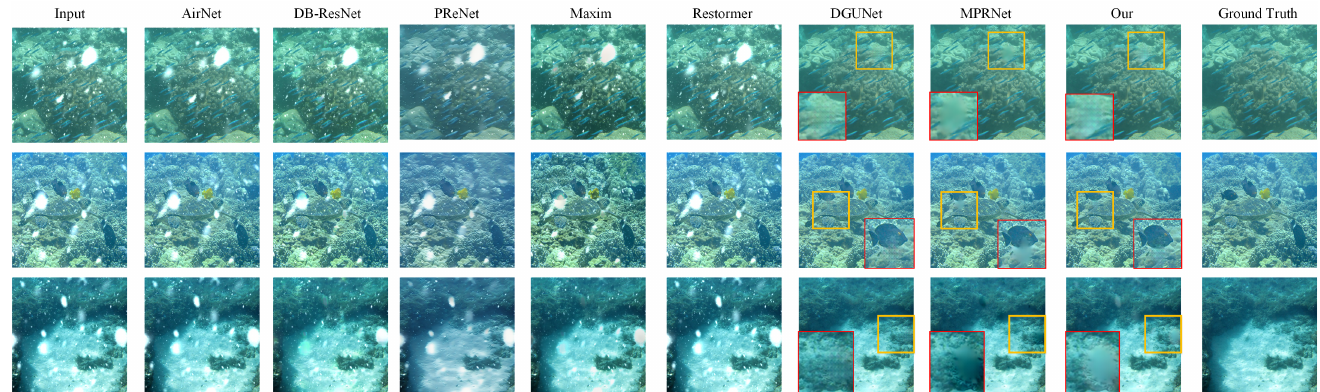
Figure 8. Comparing the results of UIR-Net with those of seven other methods on the MSIRB